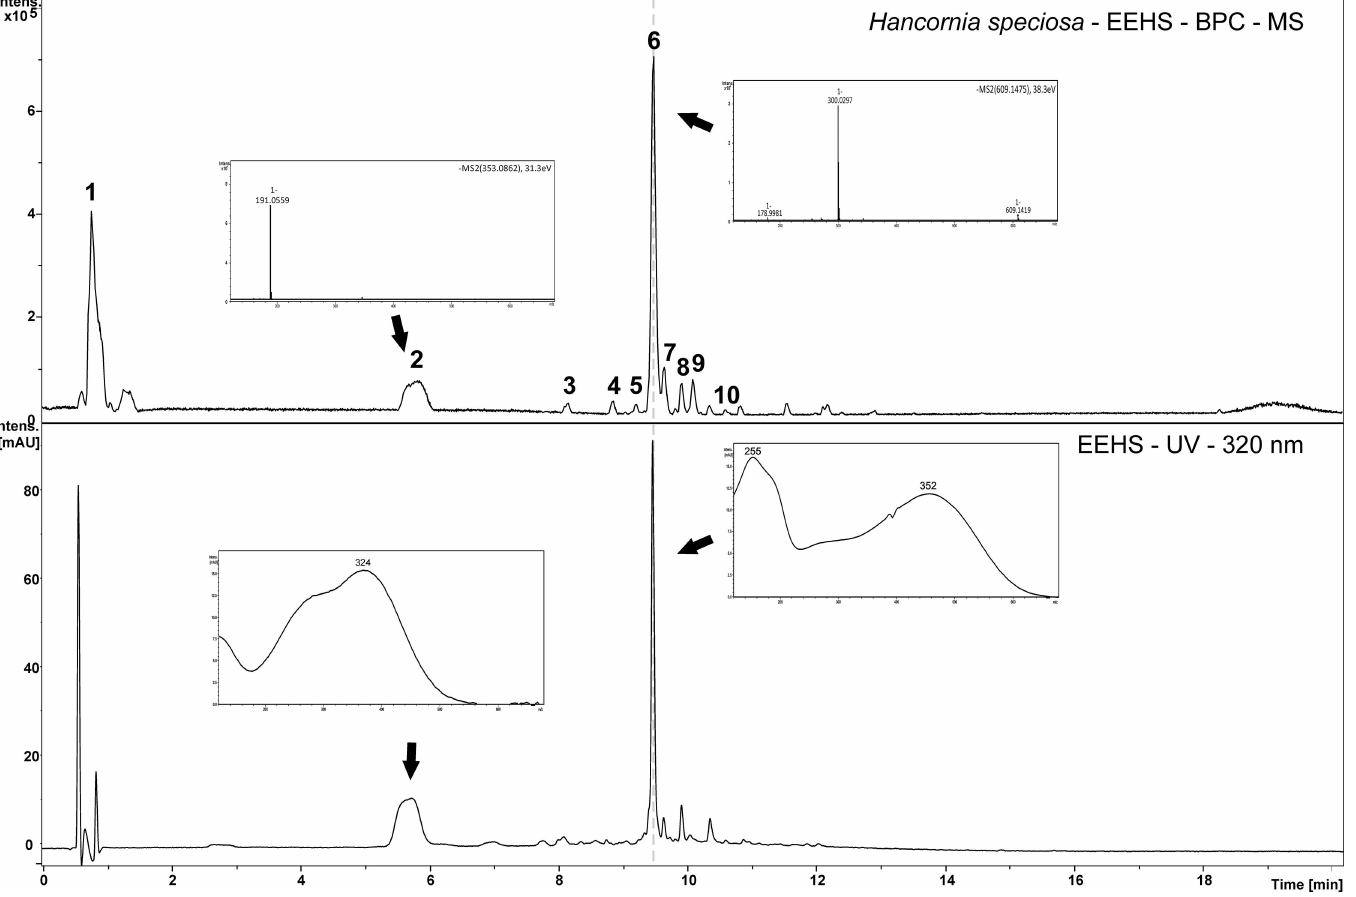
Fig 1. Chemical composition. Chromatograms obtainedby HPLC-DAD-MS/MS (negativeion mode) indicating the presenceof phenoliccompounds in the EEHS. The enlargedfigures correspond to the MS/MS spectra of the followingmain compounds: chlorogenicacid (peak 2) and rutin (peak 6).